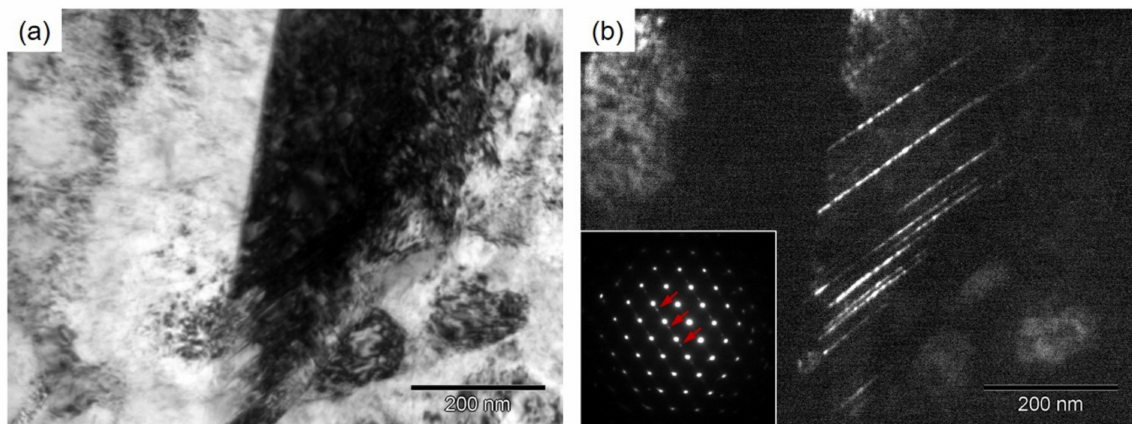
Figure 8. TEM observations of deformed HPT-produced 316LN steel annealed at 750 ◦ C: ( a ) bright field; ( b ) dark field.